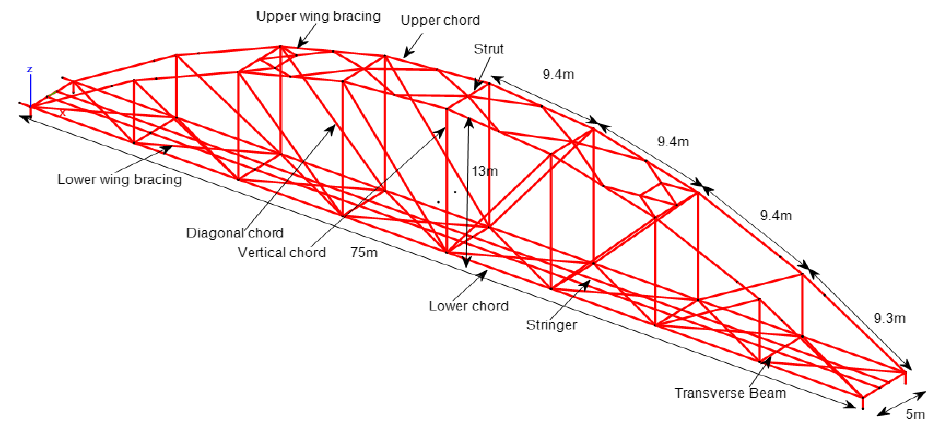
Figure 2. Main structural elements.